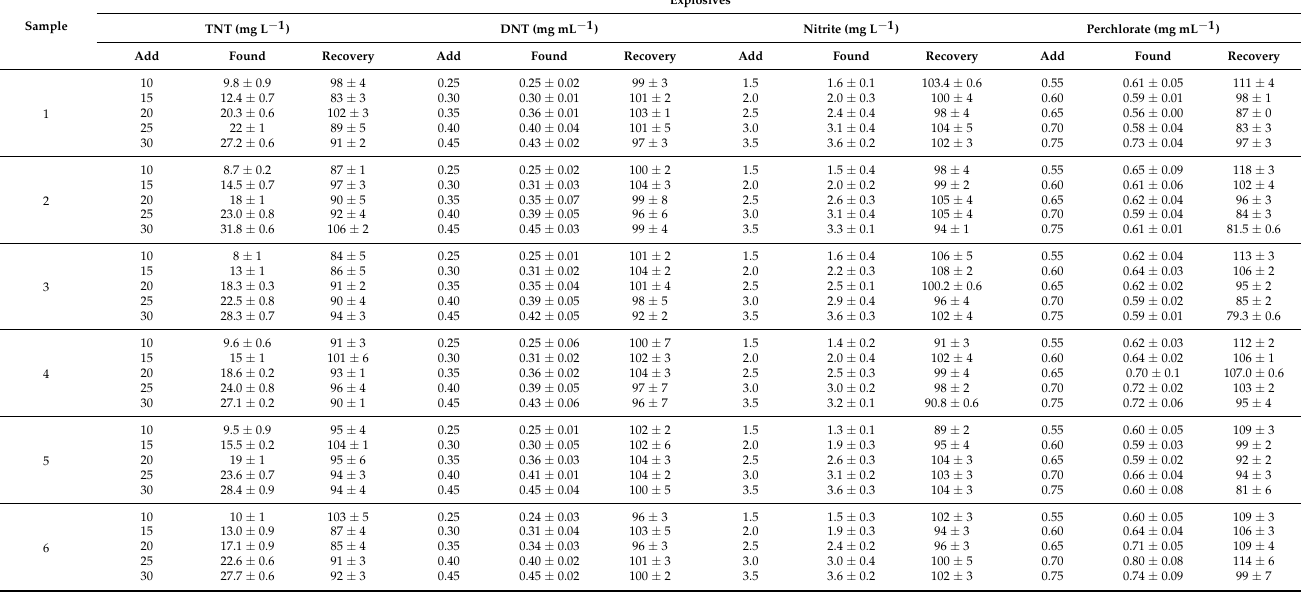
Table 6. Recoveries from six different substrate